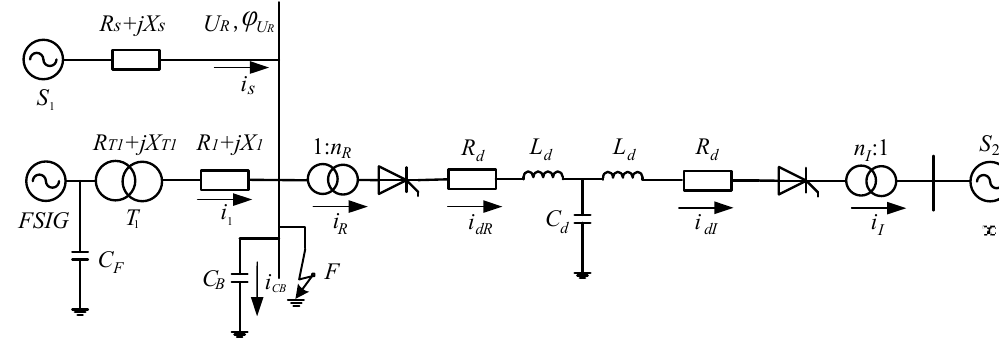
Figure 1. Schematic of the investigated system.